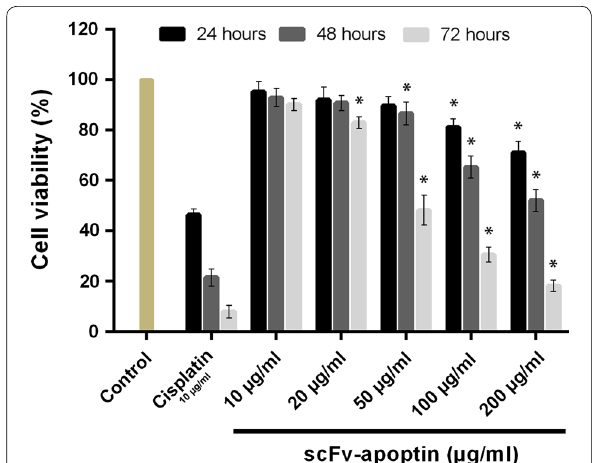
Fig. 4 Cytotoxicity of anti-CD22 scFv–apoptin against Raji cells at 10, 20, 50, 100 and 200 µg/mL of the protein concentrations. Incubation time was 24, 48 and 72 h. Data are represented as mean deviation from 3 experiments performed in triplicates (* p < 0.05